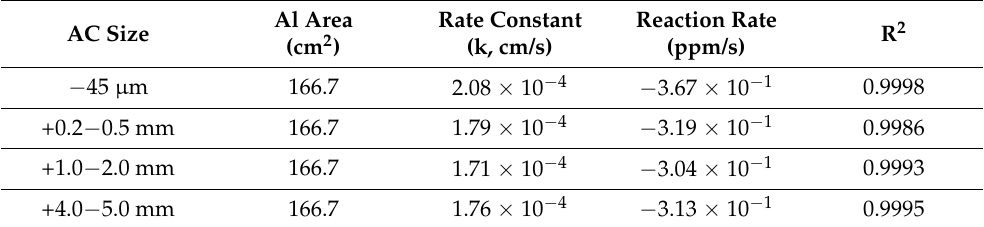
Figure 3. ( a ) The effects of AC size on the recovery of Au ions, and ( b ) the plot of rate constant/rate vs AC size for the cementation reaction by galvanic interaction of Al and AC in ammonium thiosulfate system (Note that reaction rate has a minus value). Table 3. Summary of rate constant for the cementation of Au onto the Cu-AC-Al as a function of AC size (base conditions: 10 mL solution containing 1 M of Na 2 S 2 O 3 , 0.5 M of NH 3 , 0.25 M of (NH 4 ) 2 SO 4 and 10 mM of CuSO 4 , and 0.3 g mixture (0.15 g Al and 0.15 g AC) at 25 ◦